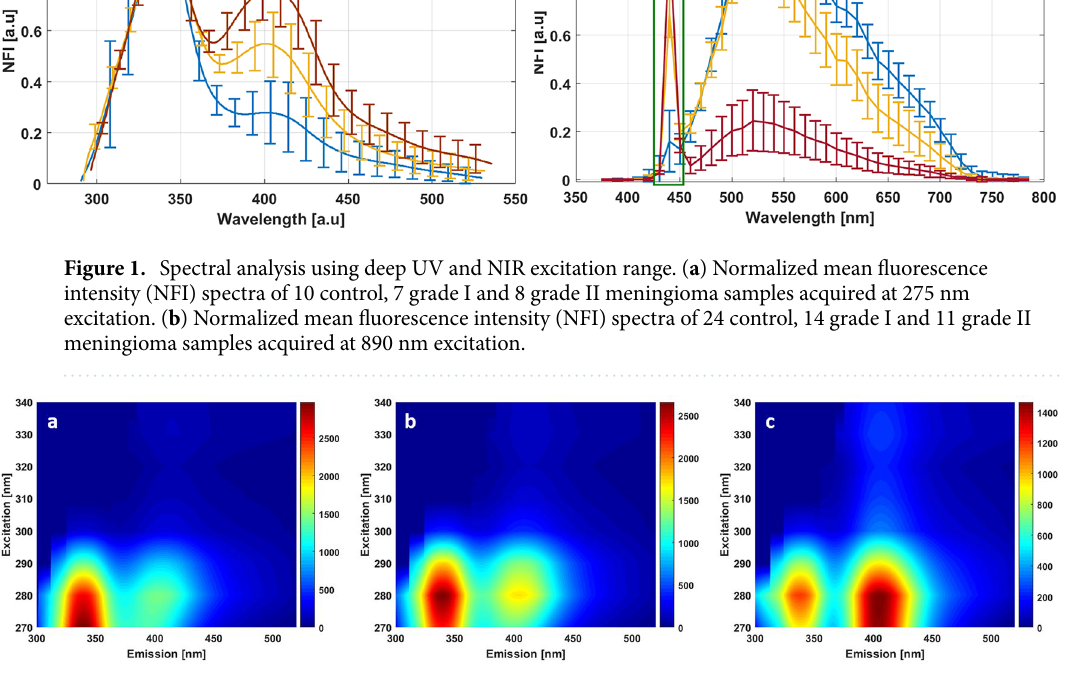
Figure 2. ( a ) Excitation Emission Matrix map in DUV excitation range for control ( a ), grade I ( b ) and grade II meningioma ( c ). The colorbars of each map reflects the emission intensity ot the spectral